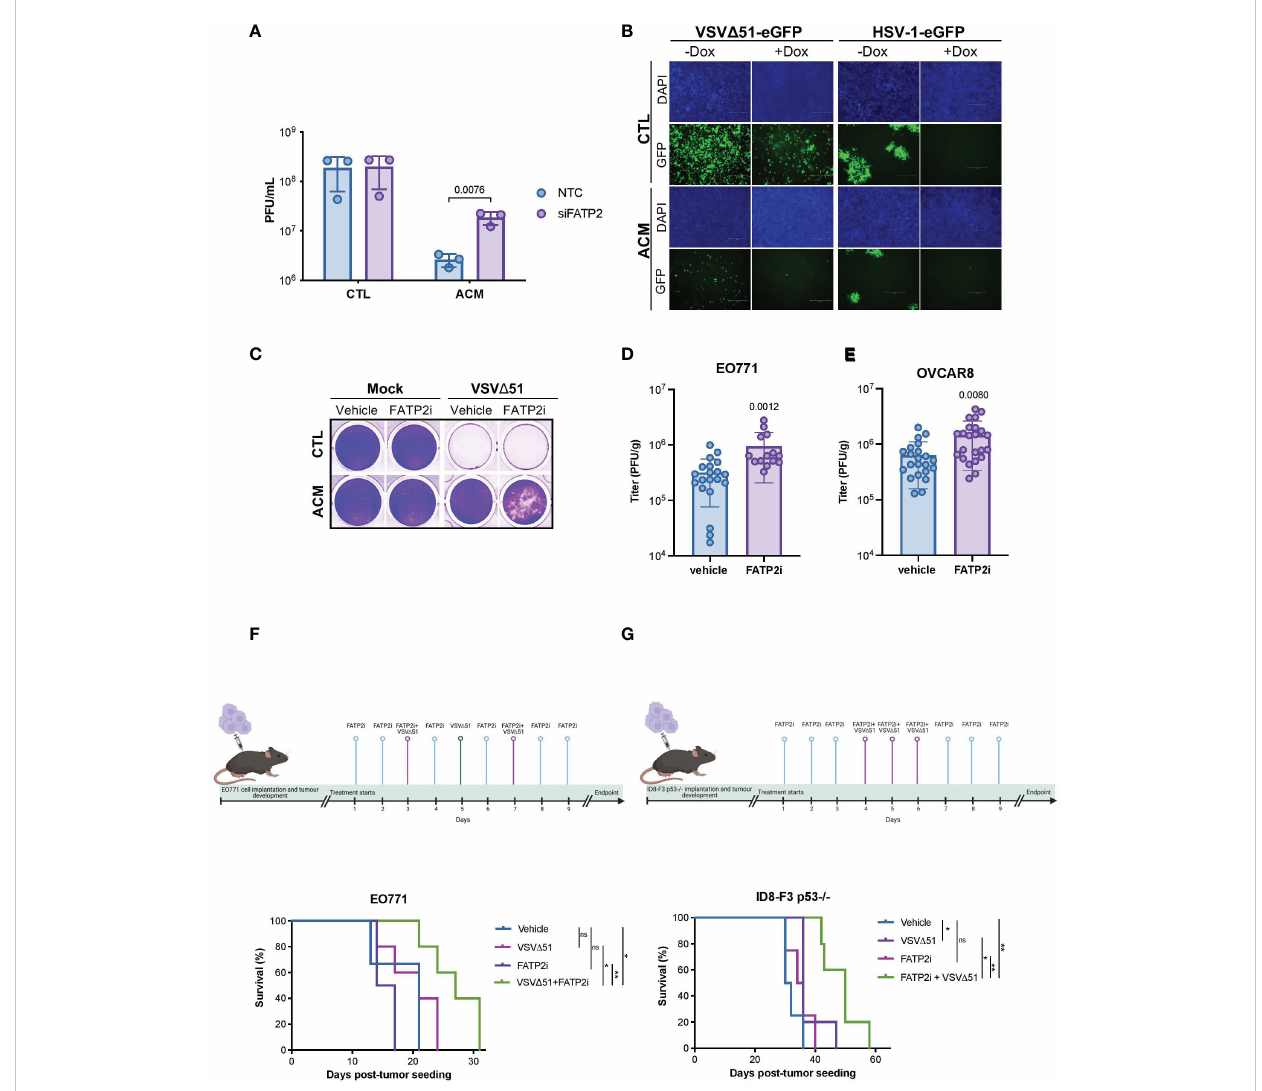
FIGURE 4 Blocking fatty acid uptake can resensitize cancer cells to OV infection and improve response to OV therapy. (A) OVCAR8 cells were transfected with siRNAs targeting FATP2 ( SLC27A2 ) for 16 hours and then infected with VSV D 51 (MOI 0.05) for an hour. The virus inoculum was removed and replaced with CTL medium or ACM. The supernatants were titrated by plaque assay 48 hpi. Data indicate the mean ± SEM (n=3). Two-way ANOVA, Bonferroni ’ s multiple comparisons test on log 10 transformed data. (B) Representative images of doxycycline (Dox) inducible FATP2 expressing OVCAR8 cells cultured in ACM or CTL medium and infected with VSV D 51 (MOI 0.01, 48 hpi) or oncolytic HSV-1 (MOI 0.01, 72 hpi) are shown. (C) OVCAR8 cells cultured in CTL medium or ACM and treated with vehicle control or a FATP2i (Lipofermata 0.24 m M) were infected with VSV D 51 (MOI 0.1) and stained with crystal violet (96 hpi). (D, E) A single dose of VSV D 51 was delivered IT into FP E0771 (n=14-20 per group) or OVCAR8 (n=22 per group) tumors. After 48 hours post-delivery, virus titers were quanti fi ed. Data represent mean values ± SEM. Unpaired two-tailed t-test. (F) Timeline for VSV D 51 and FATP2i treatment of EO771 bearing mice and Kaplan Meier survival analysis of EO771 fat-pad tumor bearing C57bl/6 mice received vehicle (n=3), FATP2i (3mg/kg) (n=4), VSV D 51 (1E8 PFU) (n=5) or both FATP2i and VSV D 51 (n=5) by intratumoral delivery as indicated in the experimental timeline. (G) ID8-F3 p53 -/- intraperitoneal (IP) tumor bearing C57bl/6 mice received vehicle (n=4), FATP2i (3mg/kg) (n=4), VSV D 51 (3E8 PFU) (n=5) or both FATP2i and VSV D 51 (n=5) by IP delivery and assessed for survival as shown in the timeline. Log-rank (Mantel-Cox) test, *p <0.05, **p <0.01. ns, non-signi fi